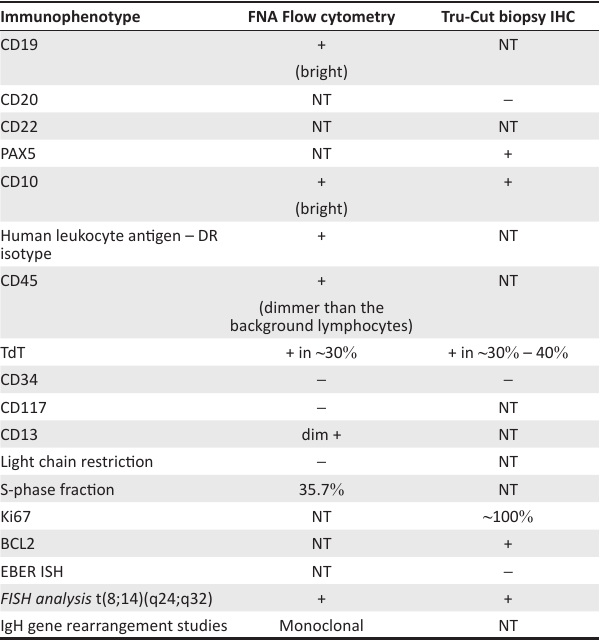
TABLE 2: Laboratory results at presentation of a 9-month-old male patient who presented to the Charlotte Maxeke Johannesburg Academic Hospital in February 2019.